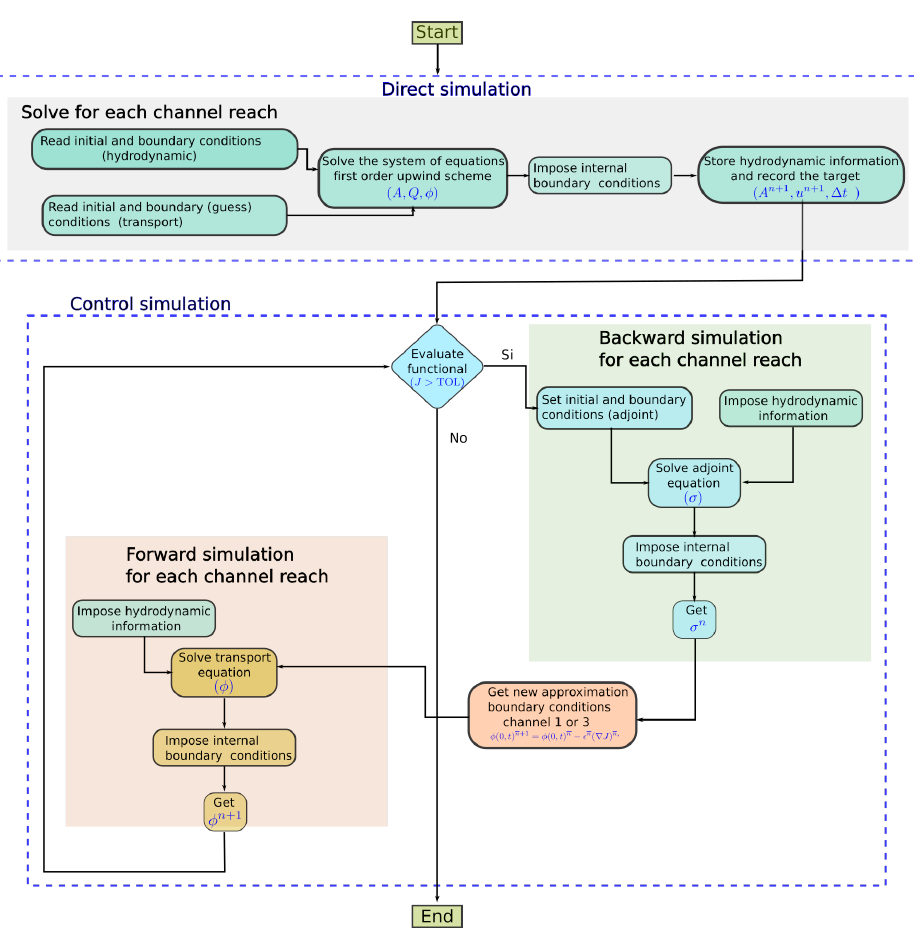
Figure 3. Scheme to reconstruct the information of the boundary condition through the adjoint and gradient-descent